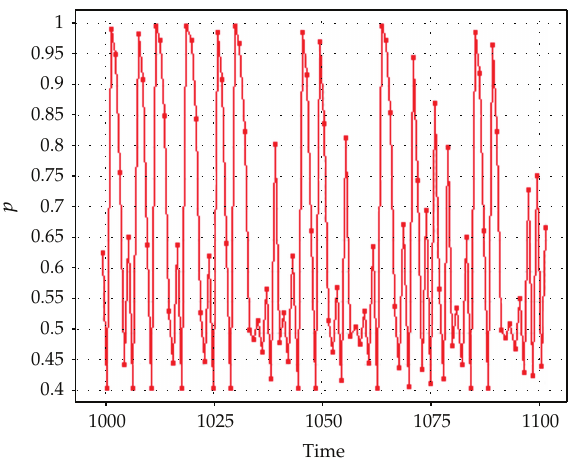
Figure 8: Grab the dollar game—trajectory of share p